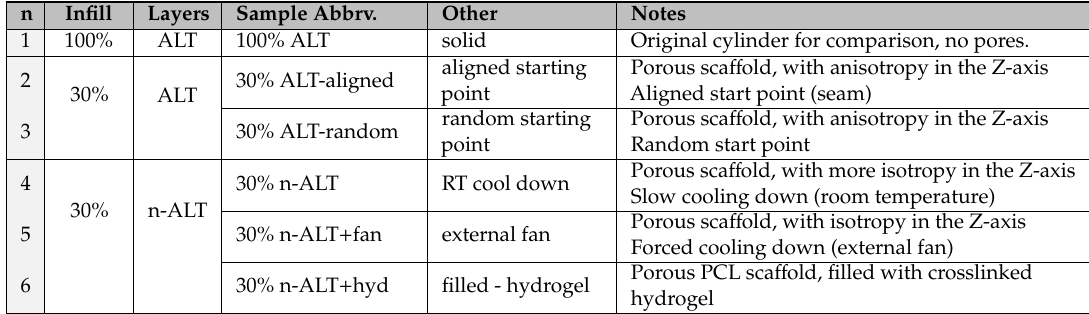
Porous sca ff old, with anisotropy in the